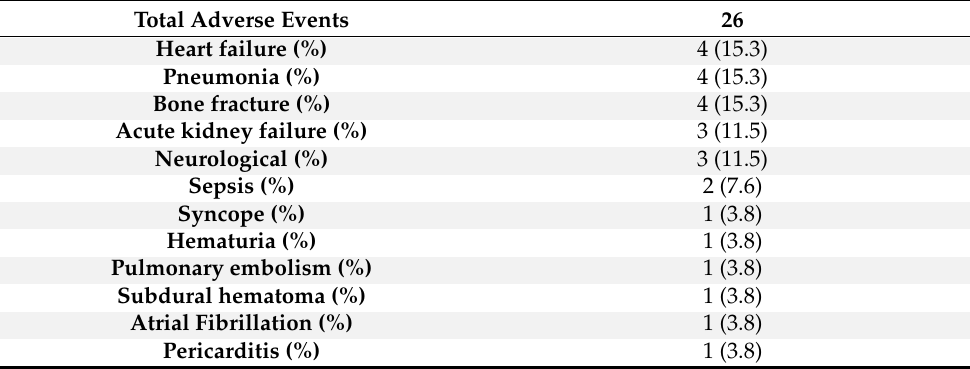
Table 2. Serious adverse events requiring hospitalization.